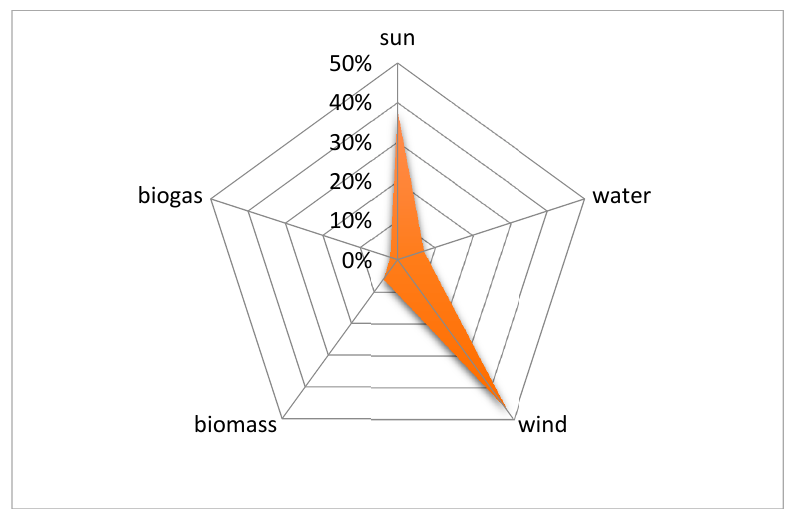
Figure 9. The structure of RES capacity in 2021 in Poland [46].